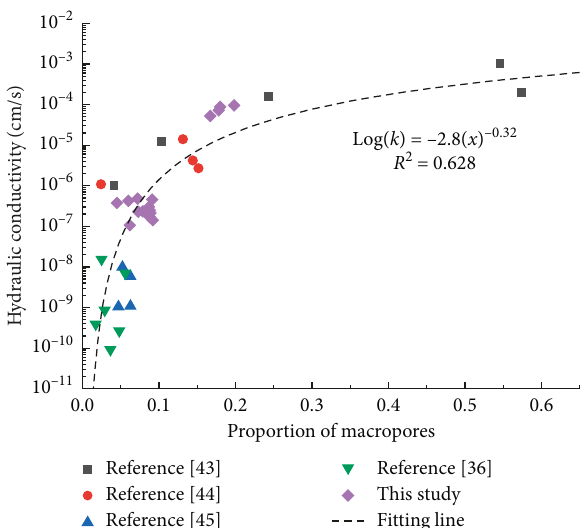
Figure 10: Variation of hydraulic conductivity with proportion of